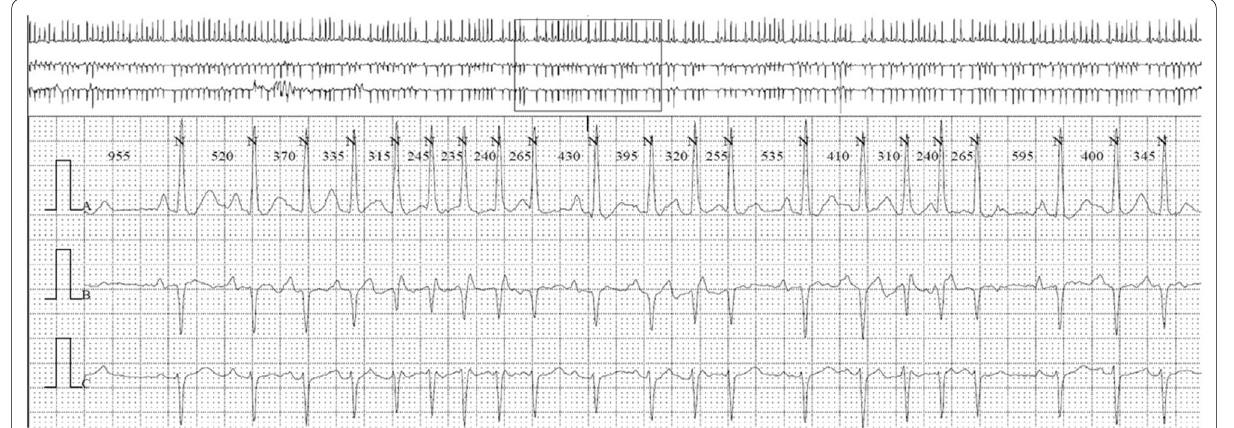
Fig. 2 A 24-h Holter monitoring strip demonstrating repetitive narrow QRS complex tachycardia alternating with rare sinus beats, suggestive of atrial